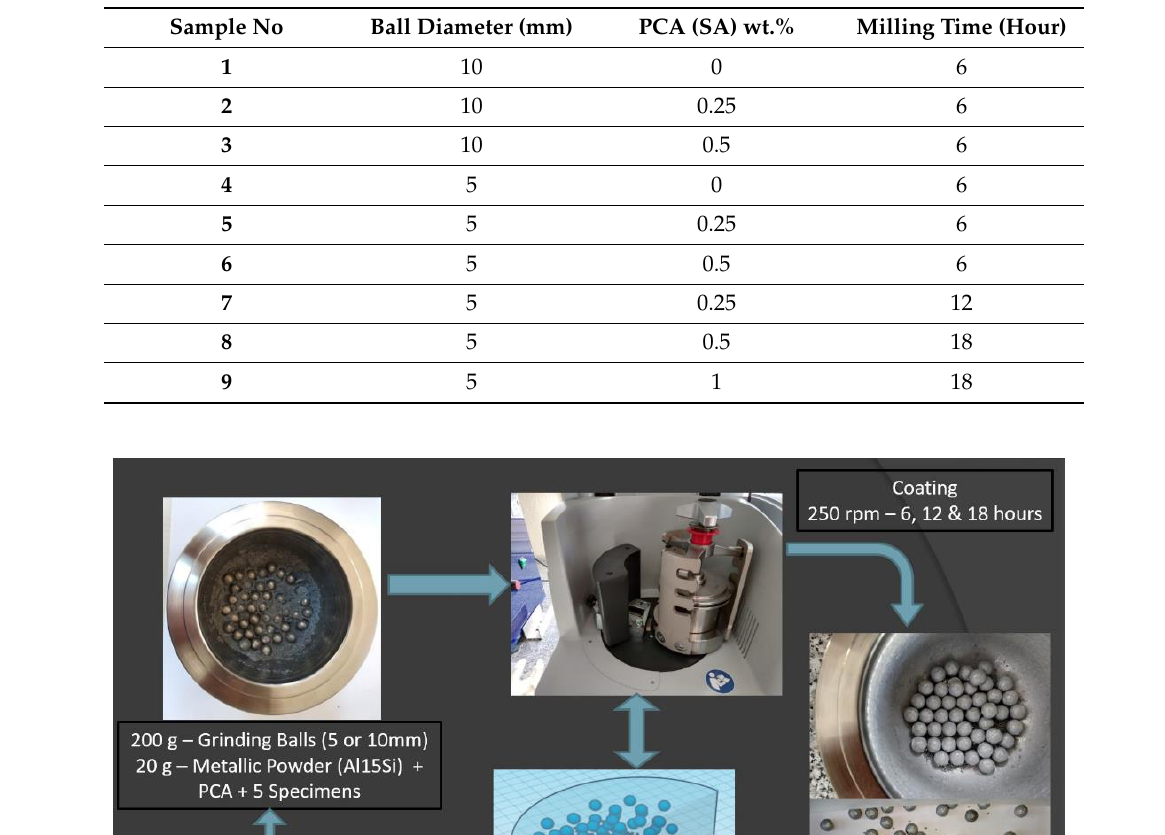
Table 2. Specifications of mechanically alloyed samples.